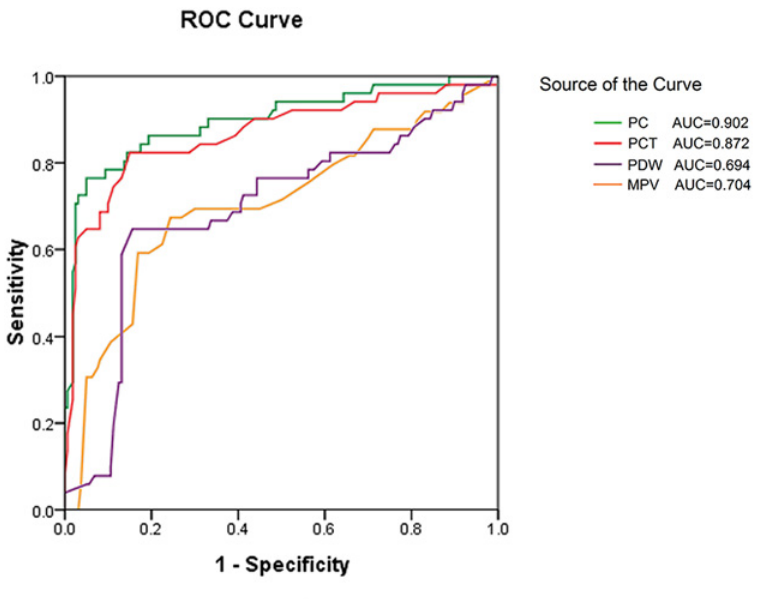
Fig 1. Receiver operating characteristic curves for the diagnosis of IFD by four platelet parameters. For each indicator, sensitivity (true positive rate) is plotted against 1-specificity (false positive rate). Accuracy is measured by the area under the ROC curve. Platelet count (PC) and plateletcrit (PCT) showed better accuracy than platelet distribution width (PDW) and hemoglobin (MPV).